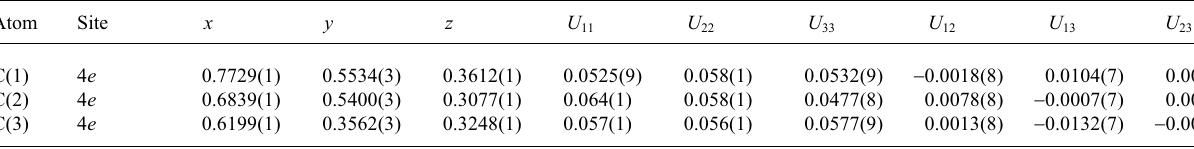
Table 3. Atomic coordinates and displacement parameters (in Å 2